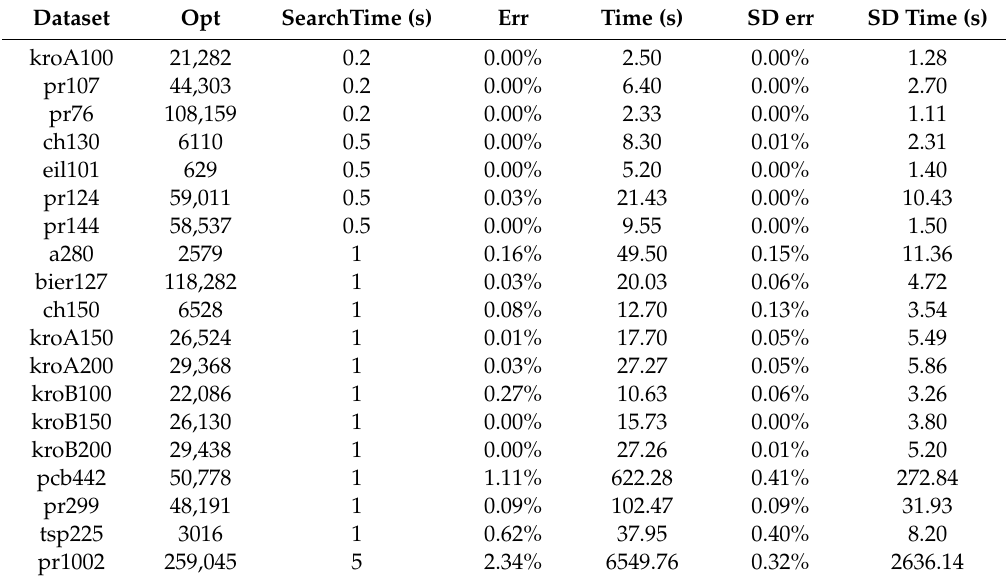
Table 5. Settings and results with standard deviations for the analyzed TSP datasets.